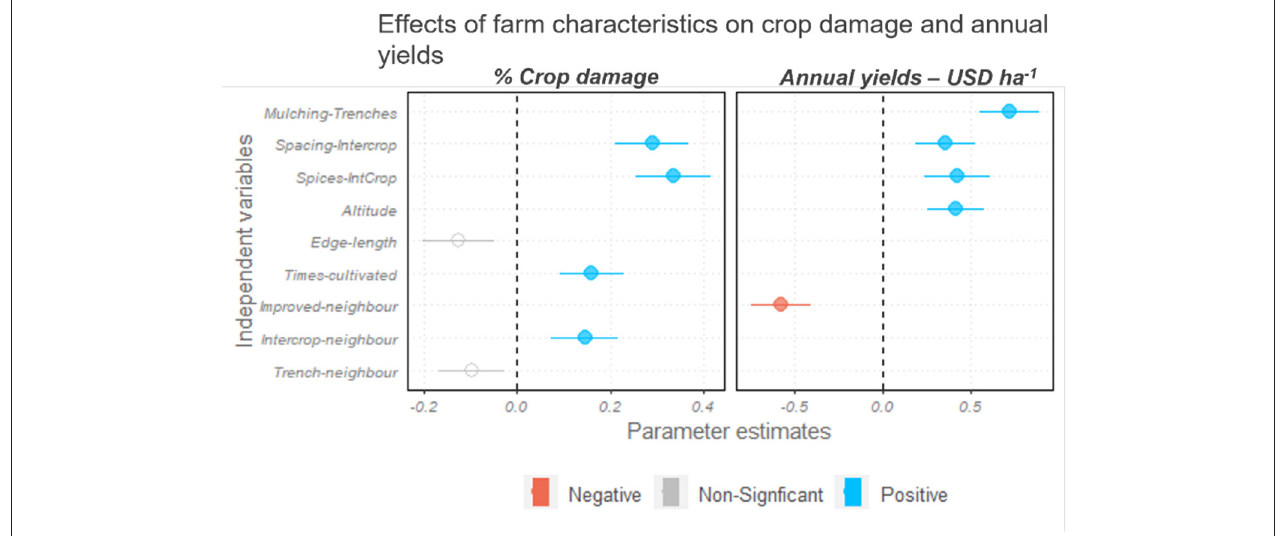
FIGURE 5 | The coefficient plot of crop damage (proportion of crop affected by pests) and crop yield earnings (Annual USD per hectare) in response to farm clusters based on management practices, neighboring field characteristics, and landscape context. The independent variables selected in the best fit model are shown. Each panel represent a different model. The positions of the circles represent β - coefficients, horizontal lines on the circles show SE, and colors signify the direction of the